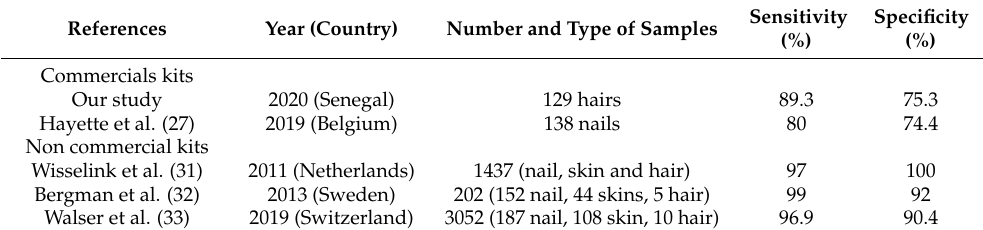
Table 4. Summary of studies comparing sensitivity and specificity between real time PCR commercials kits and in-house PCR